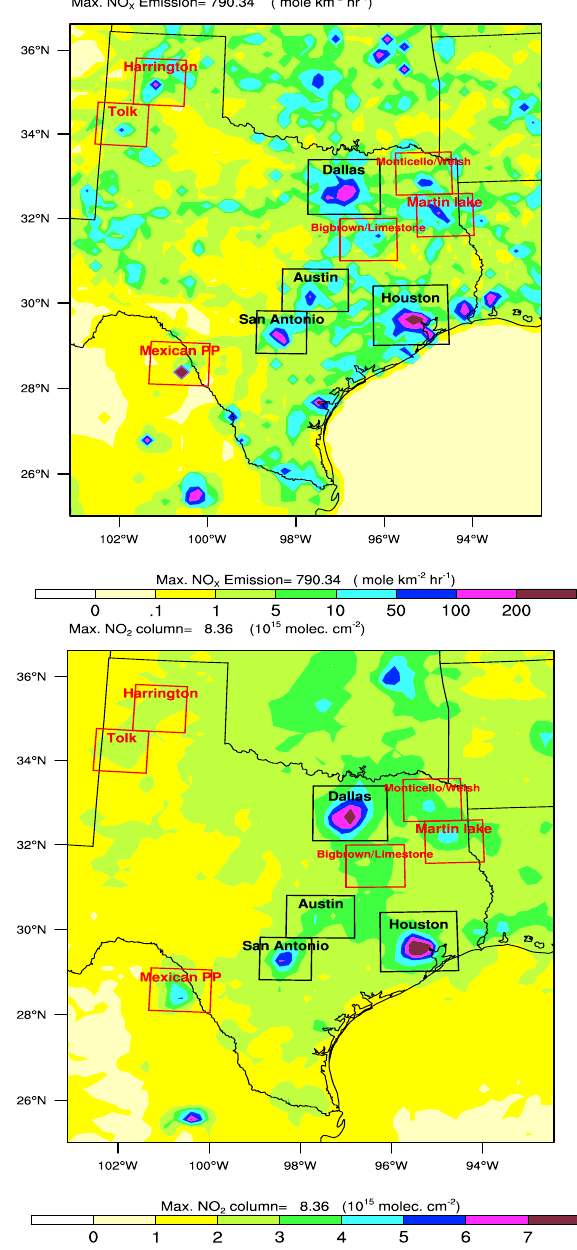
Fig. 1. Spatial distribution of NEI05-REF NO x emissions (top) and NASA OMI NO 2 columns (bottom) in the model nested do- main. The satellite columns are averaged for 26 July 2006–6 Octo- ber